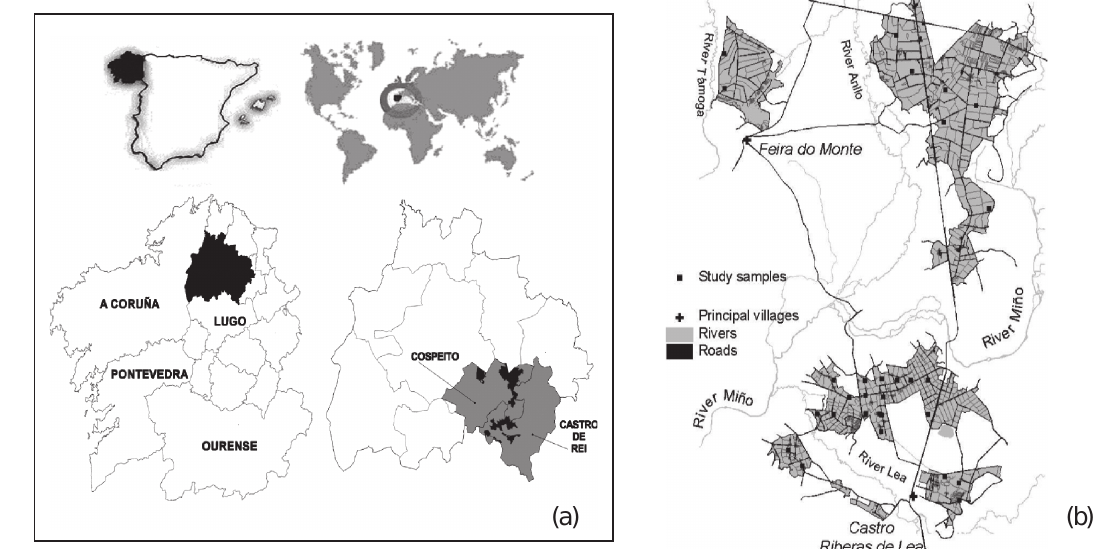
Figure 1. a) Location of “Terra Cha” in Galicia and b) Network of soil sampling.